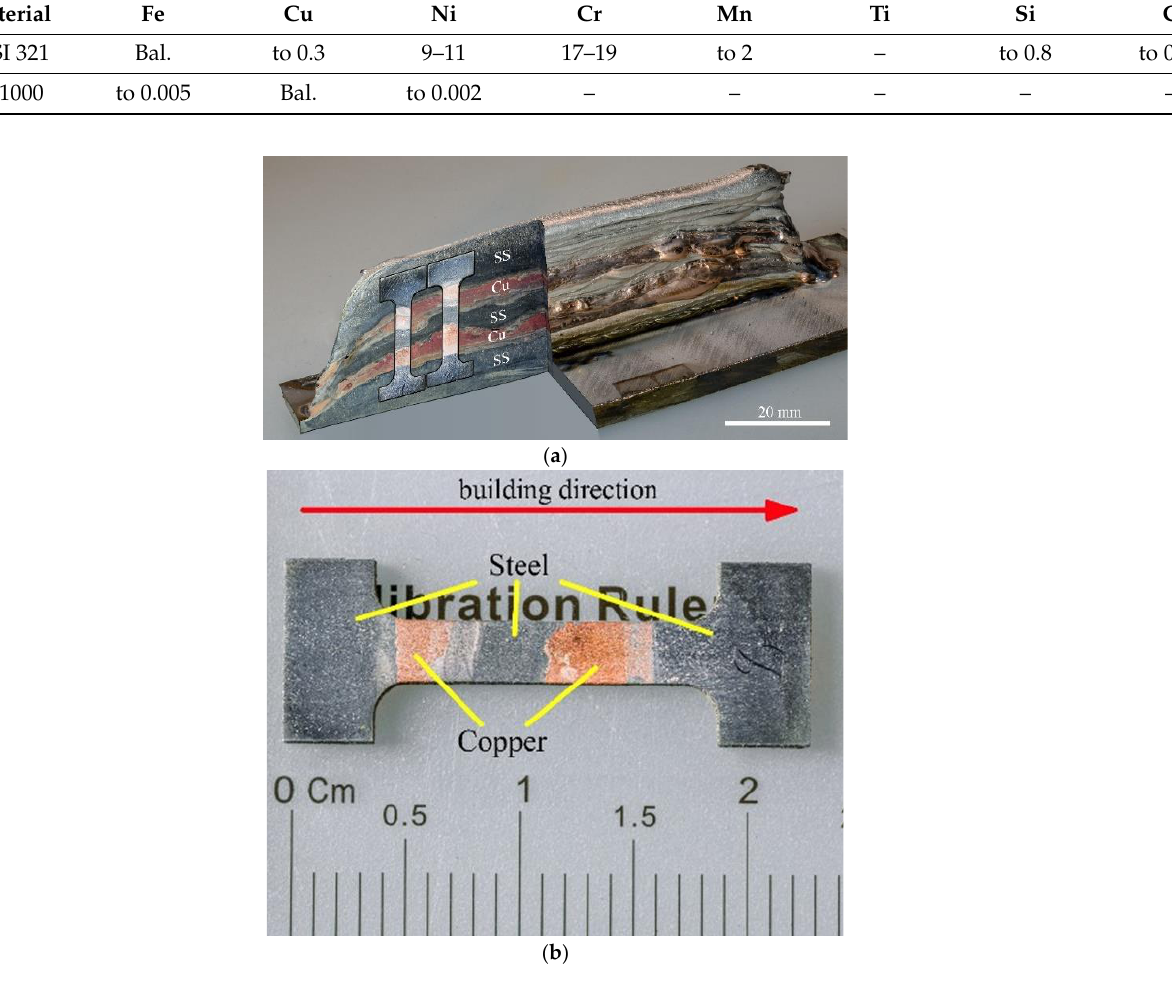
Figure 2. Sectioned “copper - steel” specimens for tensile tests ( a ). “Copper - steel” specimen for ten- sile test ( b